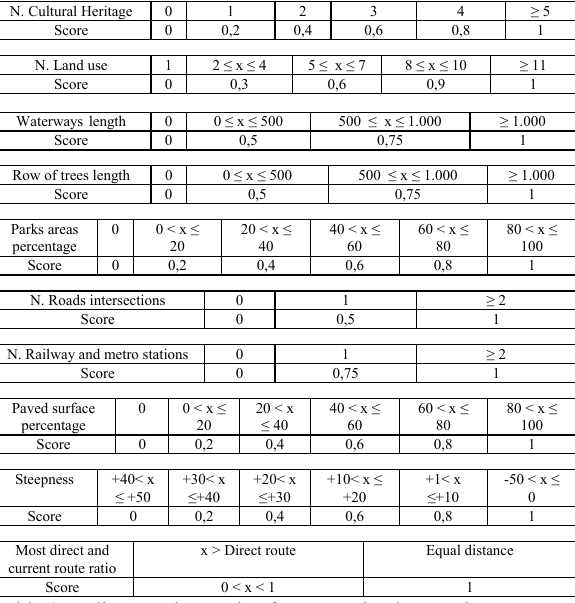
Table 2. Indicators: intervals of measured values and